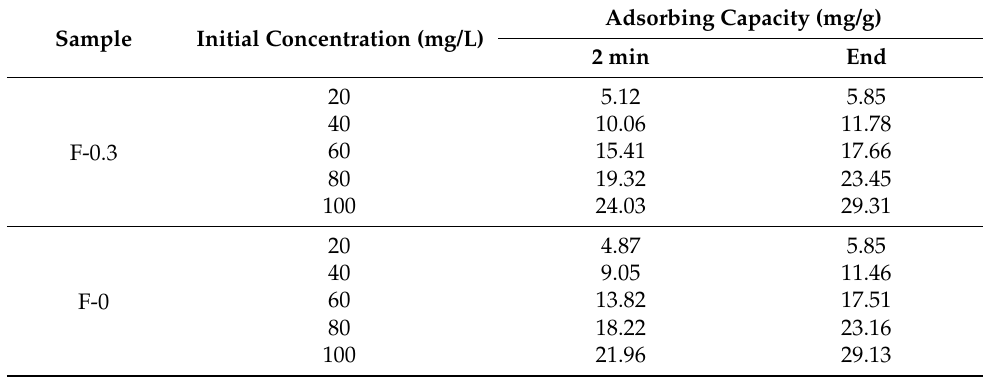
Table 1. Comparison of Cr (VI) adsorbing capacity of F-0 and F-0.3 at 2 min and equilibrium.